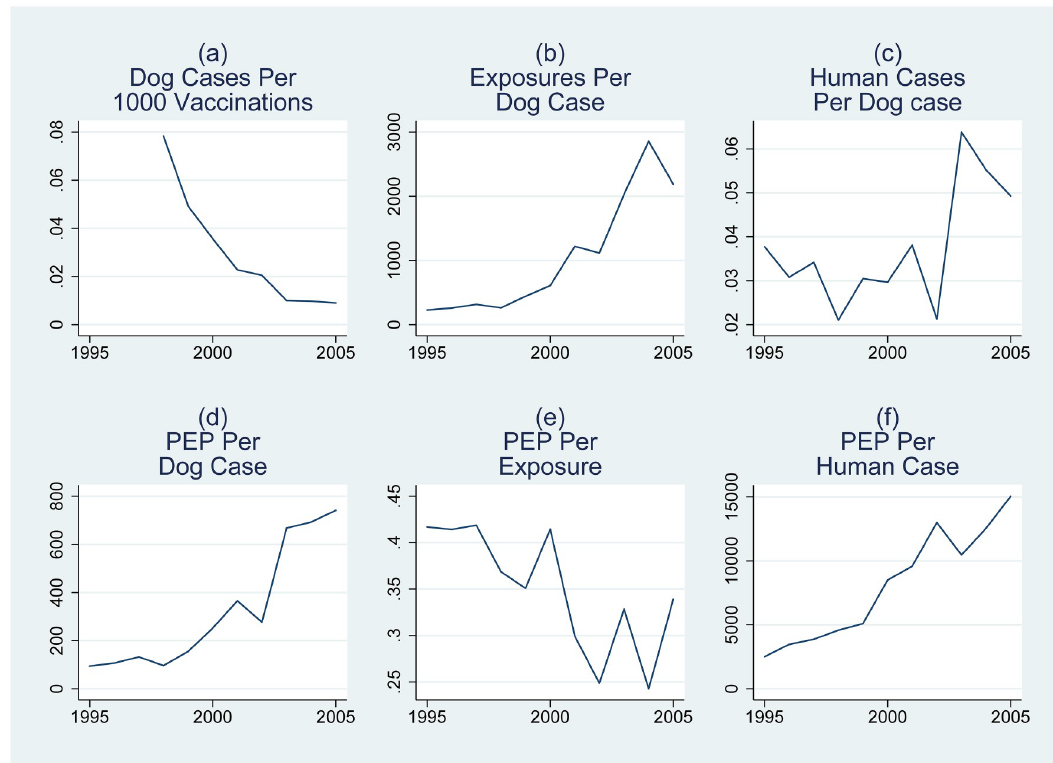
Fig 3. Time series of several ratios of focal variables aggregated over seven